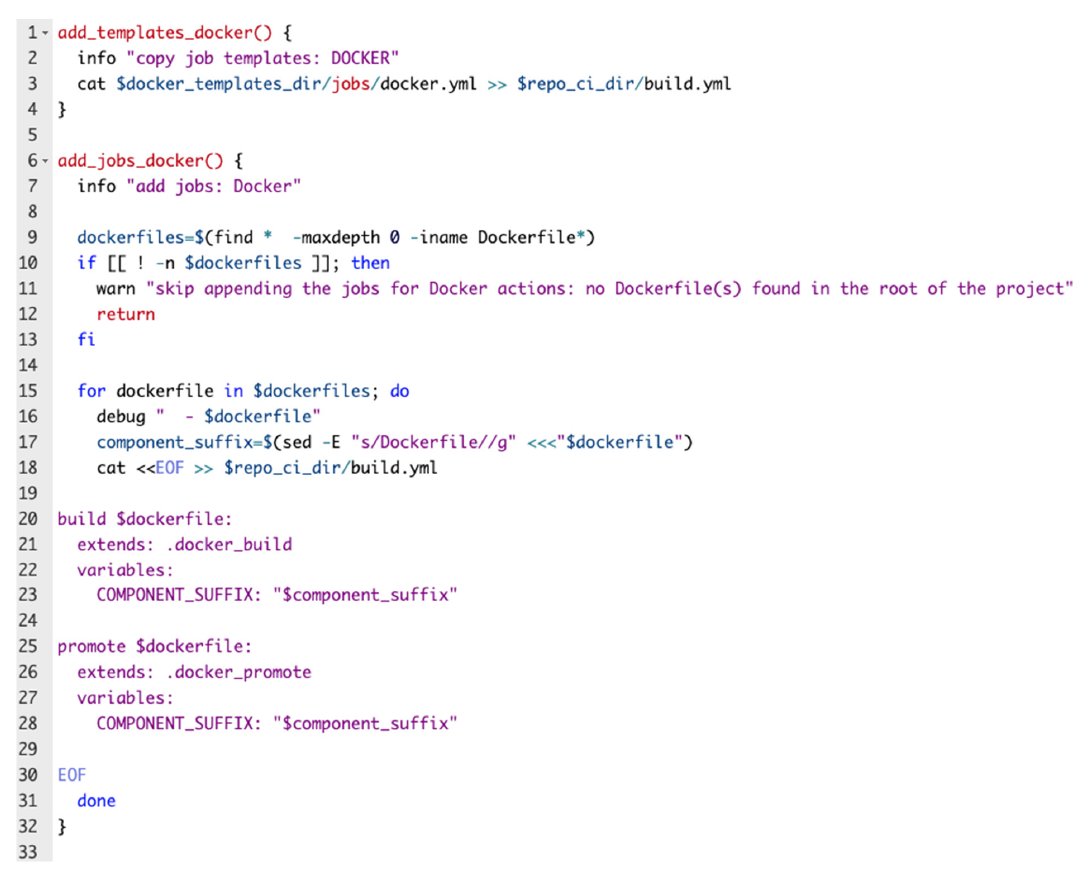
Figure 3. Pipeline generator code snippet.